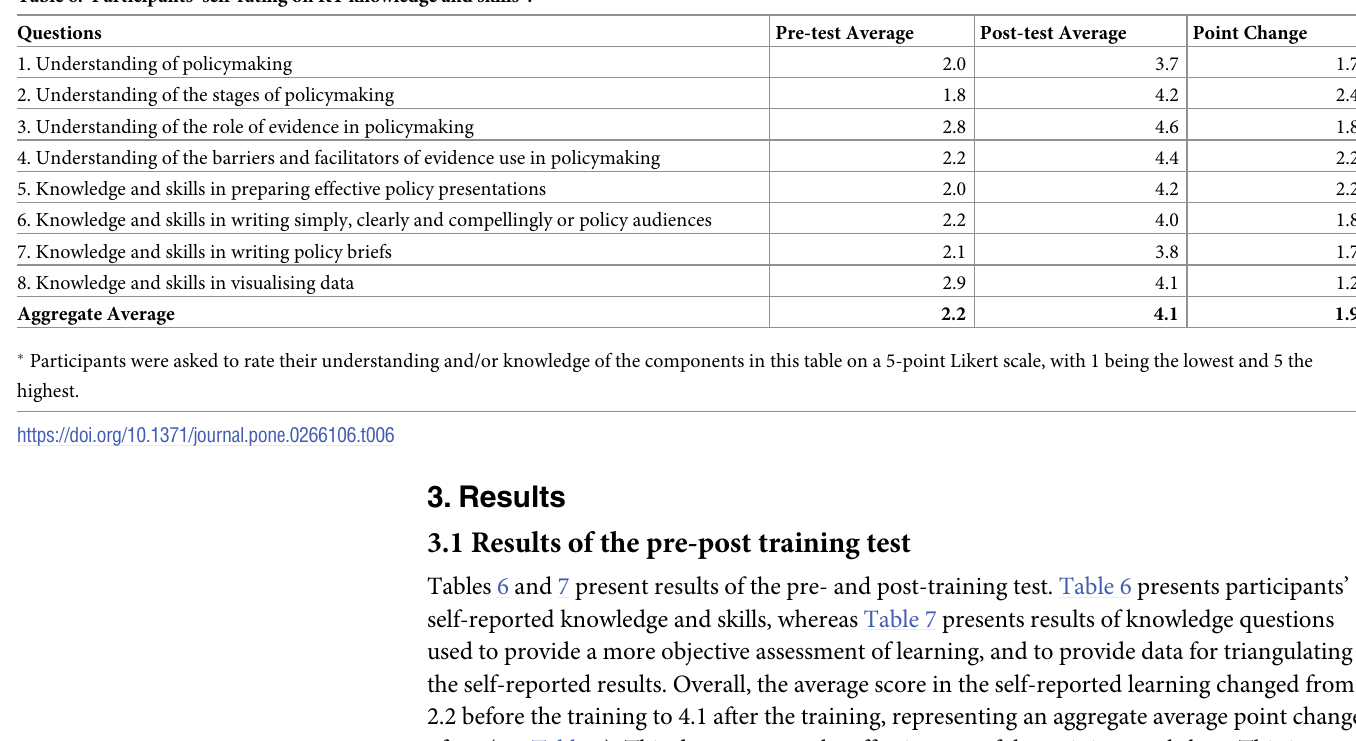
Table 6. Participants’ self-rating on KT knowledge and skills � .